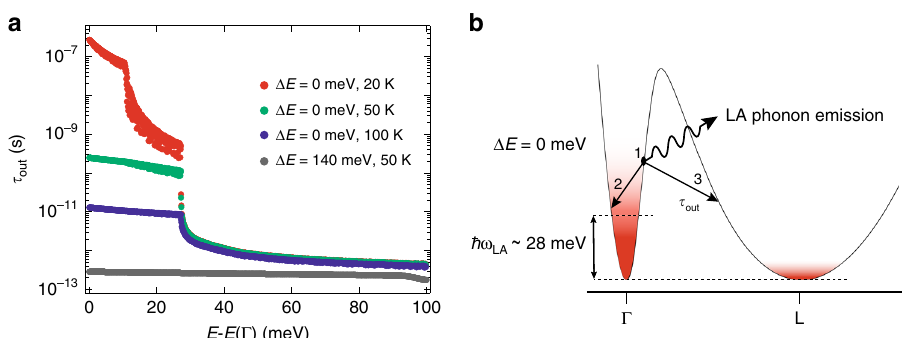
Fig. 4 Tight-binding simulation of the phonon-assisted valley transfer time from Γ to L. a The latter is computed as the scattering time from an initial state in the Γ valley to fi nal states out of the Γ valley. It is plotted as function of the energy above the bottom of the Γ valley at 50 K (grey) for the unstrained case when the offset ( Δ E ) between Γ and L is 140 meV; at 100 K (blue), 50 K (green), and 20 K (red) for the strained case with offset Δ E = 0 meV. The most effective scattering is due to the emission of a longitudinal (LA) and a transverse acoustic (TA) boundary zone phonons at energy ħ ω approximately of 28 and 10 meV, respectively. b Schematics of the conduction band with the Γ and L valleys aligned, i.e. Δ E = 0. After a carrier is optically excited in the Γ valley (1), it will relax within the Γ valley (2), or by the emission of a zone-boundary phonon — to establish momentum conservation — scatter into L (3). Carriers with energy < ħ ω LA will remain much longer at Γ because the reverse process of absorbing a phonon is much less probable, in particular at low